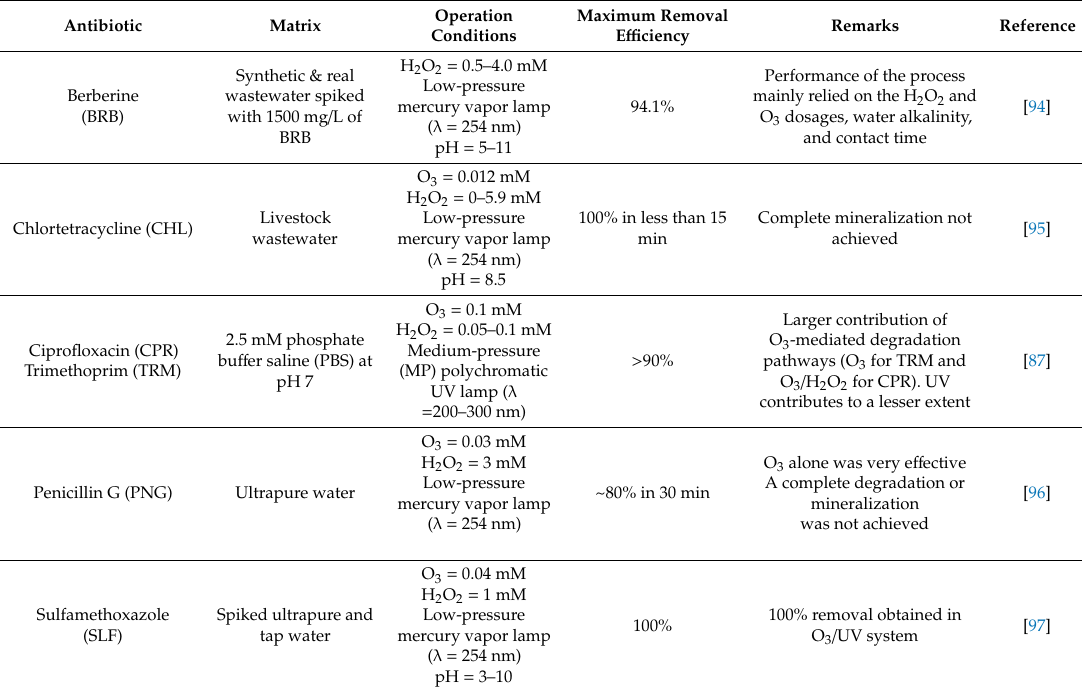
Table 8. Removal e ffi ciency of antibiotics in waters by the O 3 / H 2 O 2 / UV